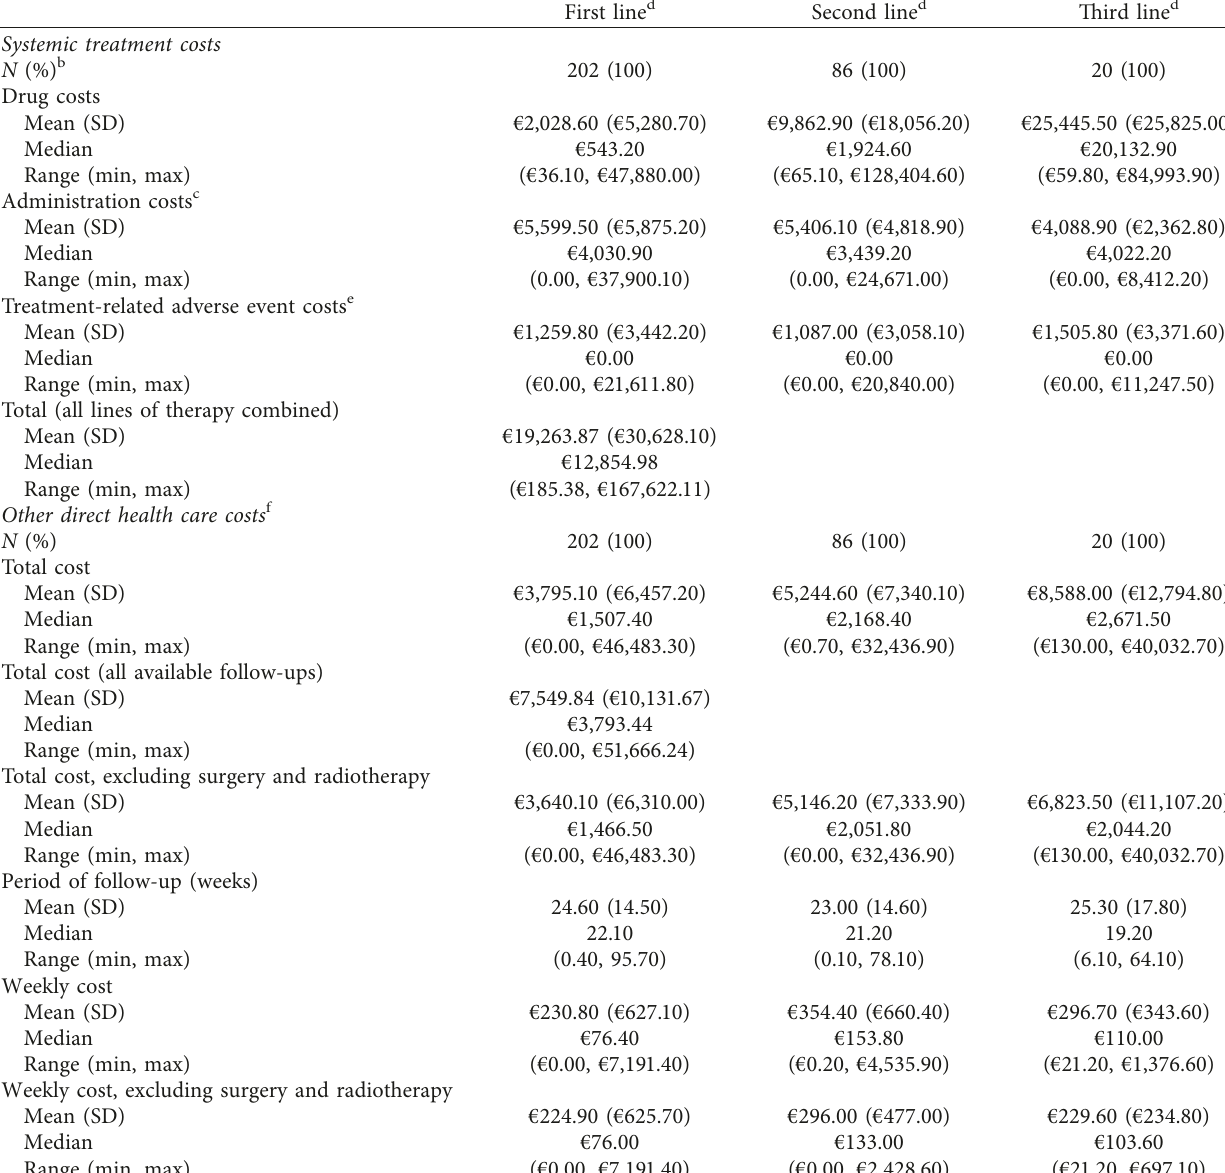
Table 5: Estimated health care costs related to treatment of advanced STS a in Spain ( n �